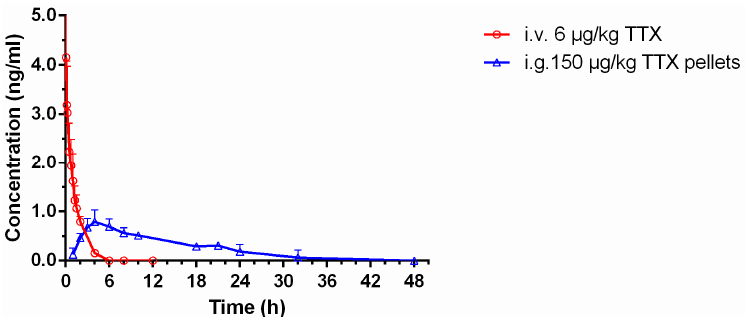
Table 3. The body weights of the SD rats after a single oral administration of sustained-release TTX pellets.